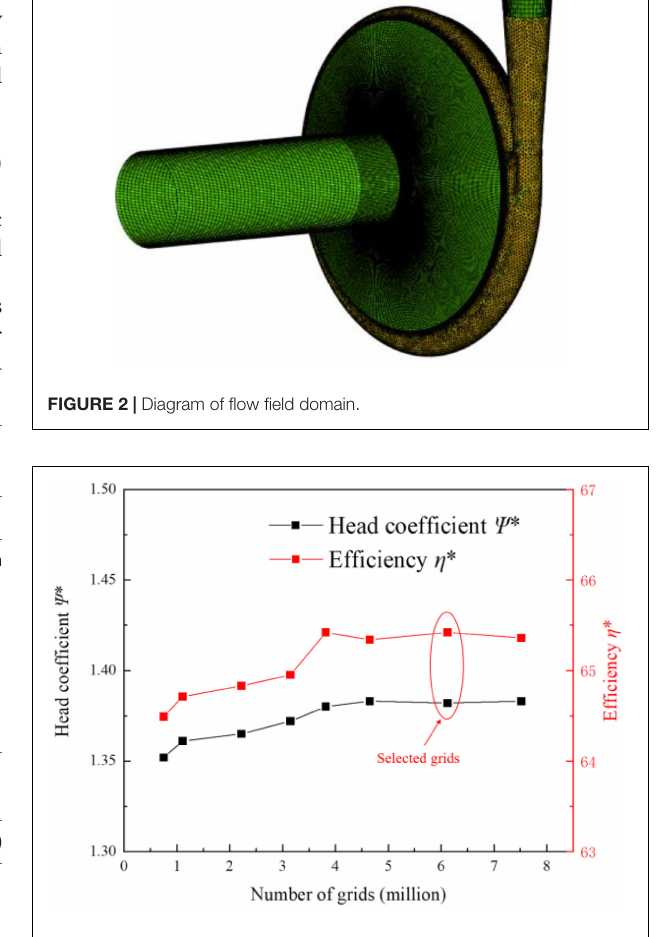
FIGURE 3 | Diagram of flow field mesh